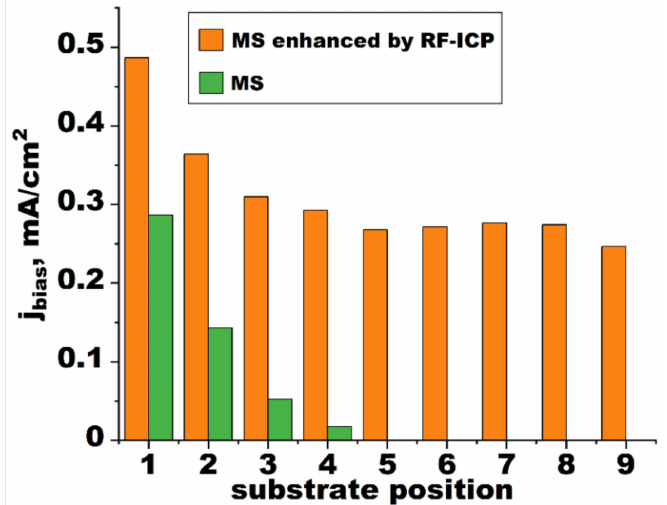
Figure 2. Ion current density ( I bias ) of substrates depending on their position in the